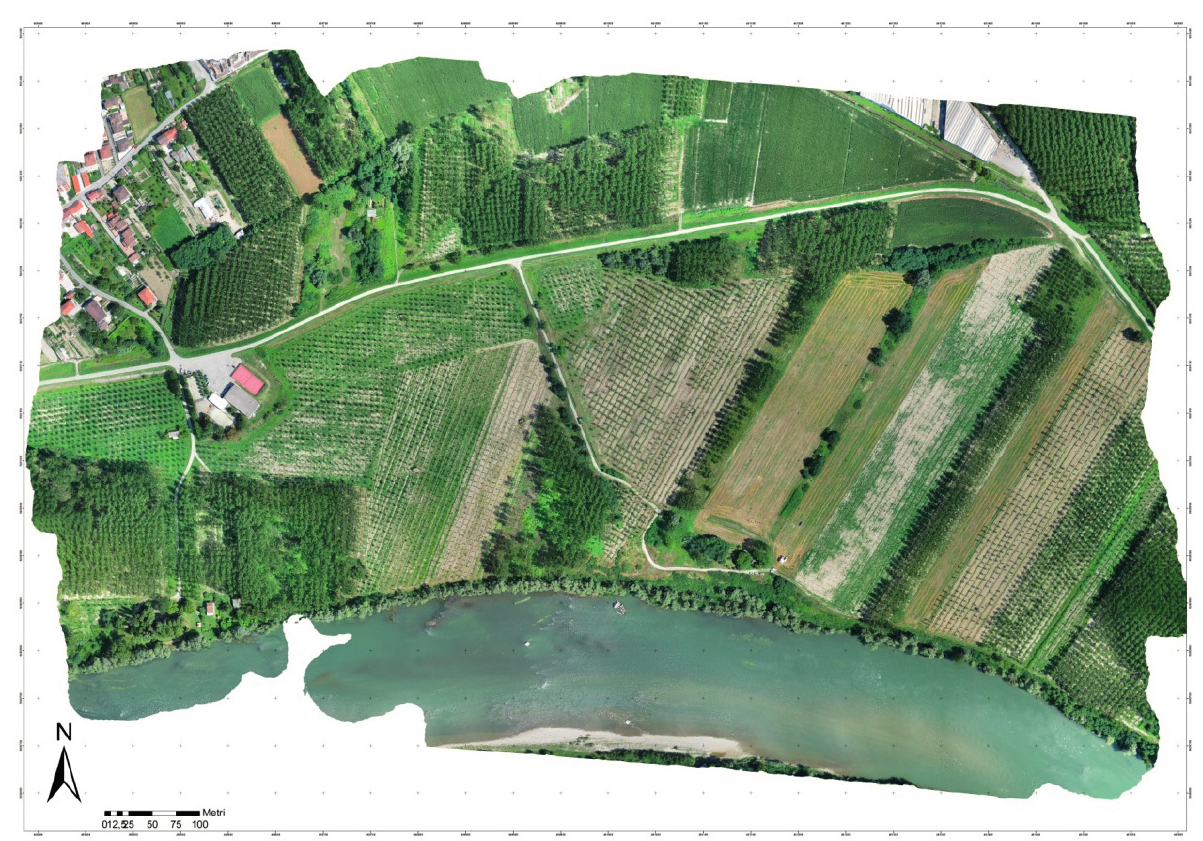
Figure 11. Orthophoto based on the images acquired with the fixed-wing UAV (direct georeferencing approach).